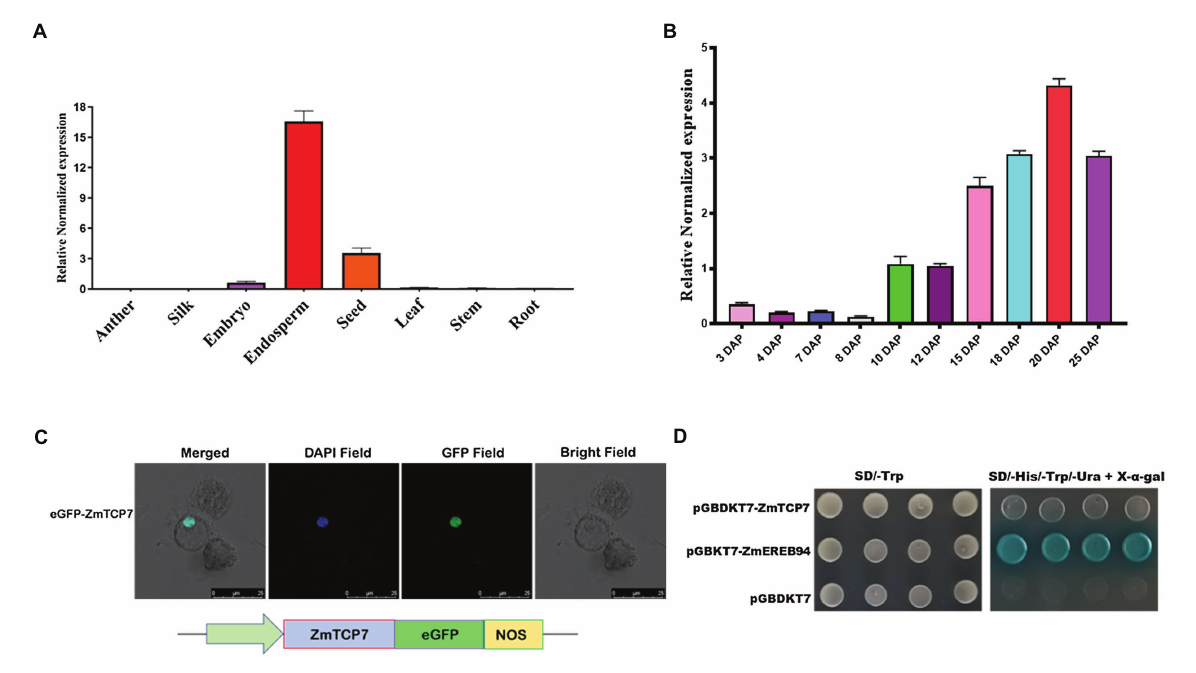
FIGURE 3 Spatiotemporal expression pattern and transcription factor characteristics of ZmTCP7. (A) Tissue-specific expression analysis of ZmTCP7 in various maize tissues by RT-qPCR. Developing endosperm and seed at 16 DAP and other tissues at 10 DAP from at least three plants were used for the tissue-specific expression analysis; (B) analysis of expression of ZmTCP7 in developing kernels between 3 and 25 DAP by RT-qPCR. The bars indicate the mean ± SD of three replicates; (C) ZmTCP7-eGFP fusion construct (lower panel) and subcellular location of the ZmTCP7-eGFP fusion protein in maize endosperm protoplast cells (upper panel): GFP, green fluorescent signal, DAPI (4,6-diaminodino-2-phynylindole), nuclear marker. Scale bar = 25 μ m; (D) analysis of ZmTCP7 transactivation in the yeast system. pGBKT7-ZmEREB94 and pGBKT7 are positive and negative controls,